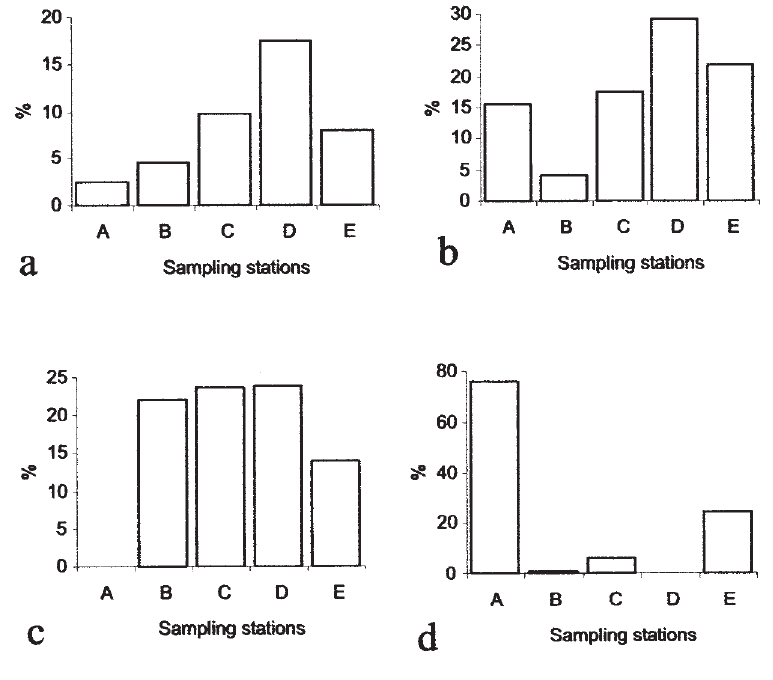
Fig. 2 . Relative frequency of individuals that feed on aquatic insects (a), fruits and seeds (b), detritus (c) terrestrial insects (d), at the sampling stations A, B, C, D, and